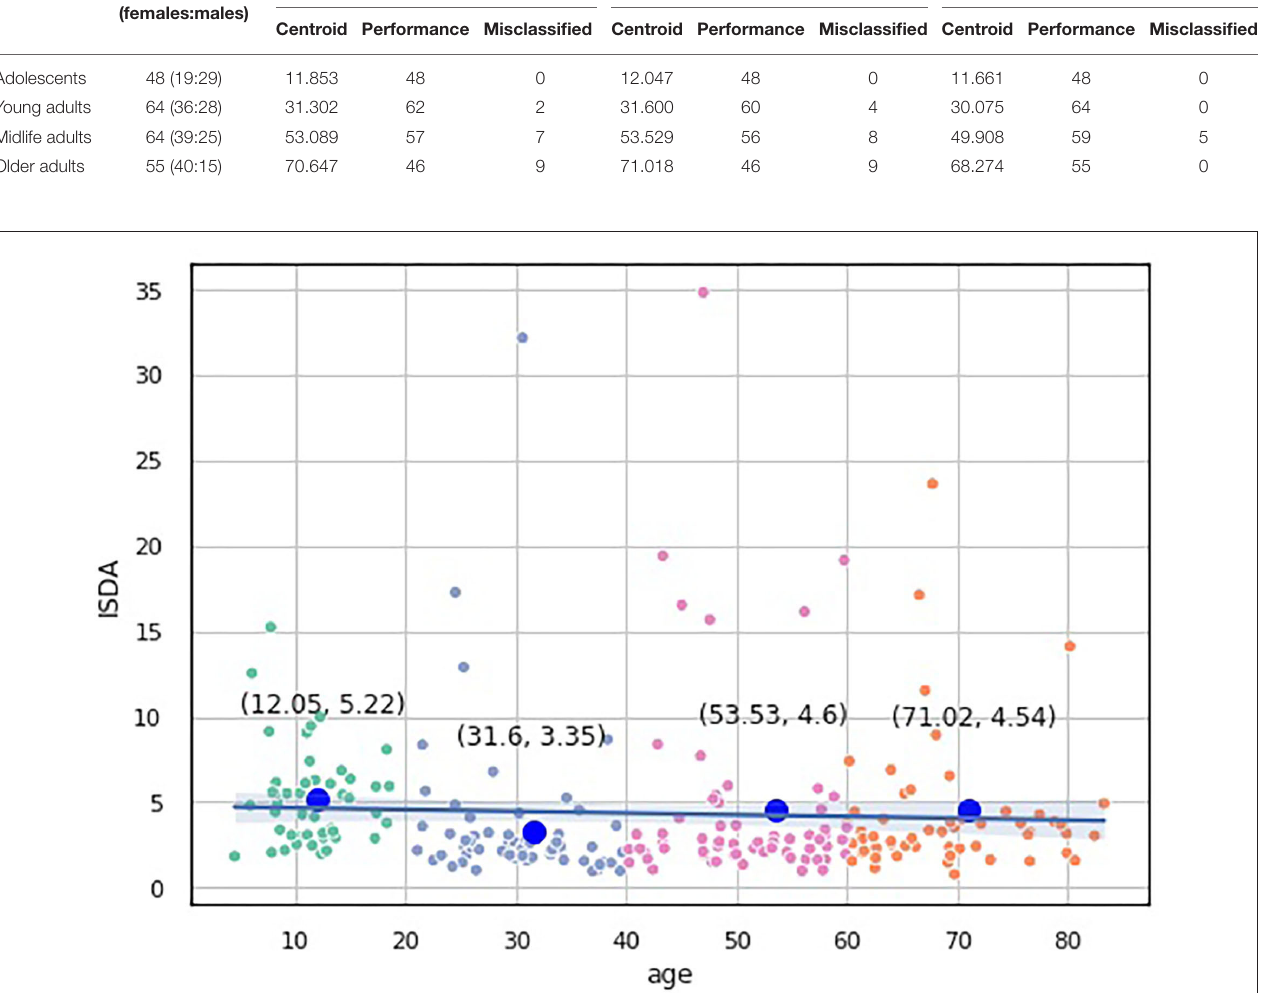
preserve almost constant values with a slight trend toward functional